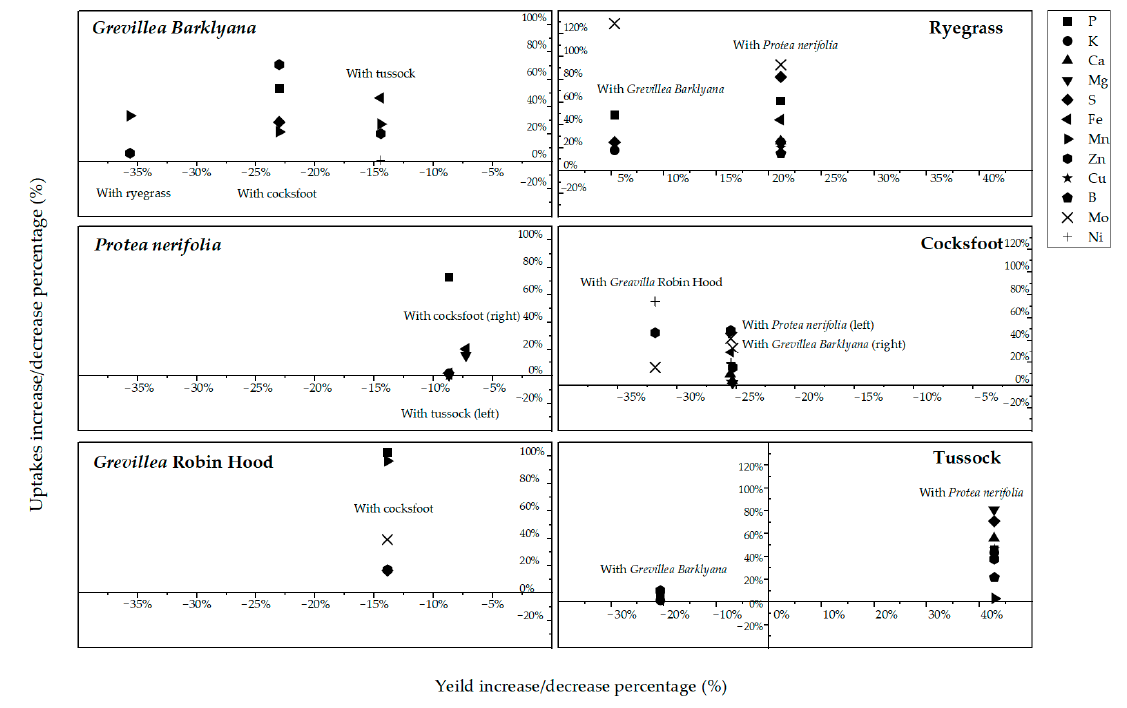
Figure 8. The percentage change in yield (horizontal axes) and total foliar uptake of key nutrients (vertical axes), when each of the protea and grass species ( Lolium perenne , ryegrass; Dactylis glomerata , cocksfoot; Poa cita , tussock grass) was grown with a companion species. Percentage change is the difference to when each species grew